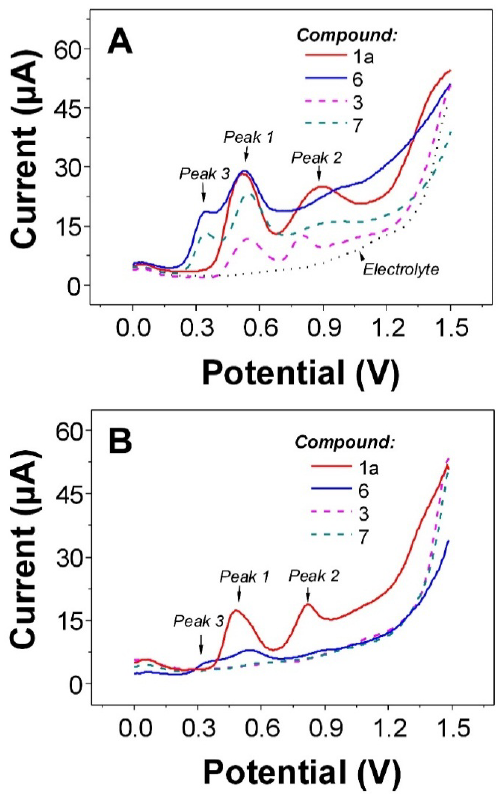
Figure 2. In situ ( A ) and ex situ ( B ) SW voltammograms of flavonolignans 1a , 3, 6 , and 7 . Non-adsorbing species in panel ( B ), i.e. , flavonolignans 3 and 7 , providing the background very similar to “Electrolyte” in panel ( A